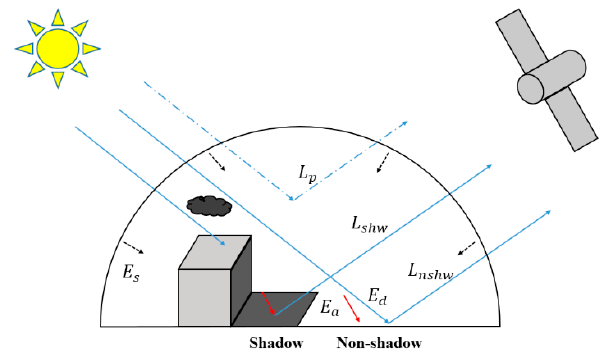
Figure 1. Illustration of the light transfer process in non-shadow and nearby shadow regions [9].